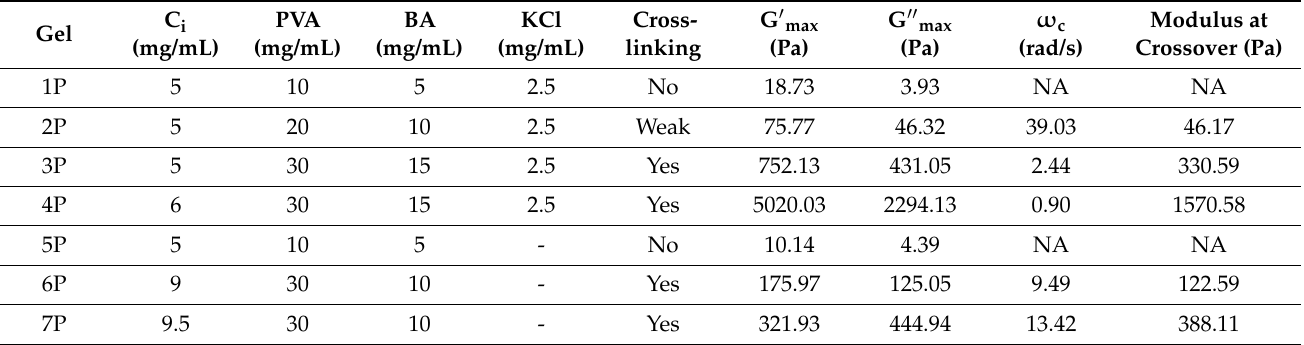
Table 2. Final concentrations of the components, and rheological and physical characterizations results of C i -PVA-BA gels. The G (cid:48) max and G (cid:48)(cid:48) max measurements were made at 25 ◦ C after increasing the pH to 7–8.